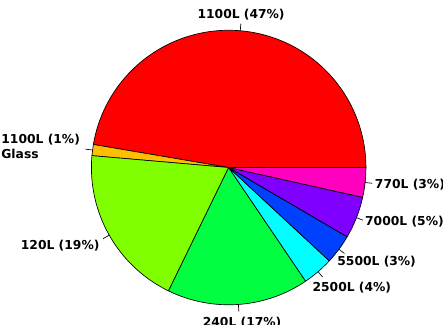
Figure 5. Bin volume distribution (domestic waste/paper-cardboard and glass) for waste collection processed in